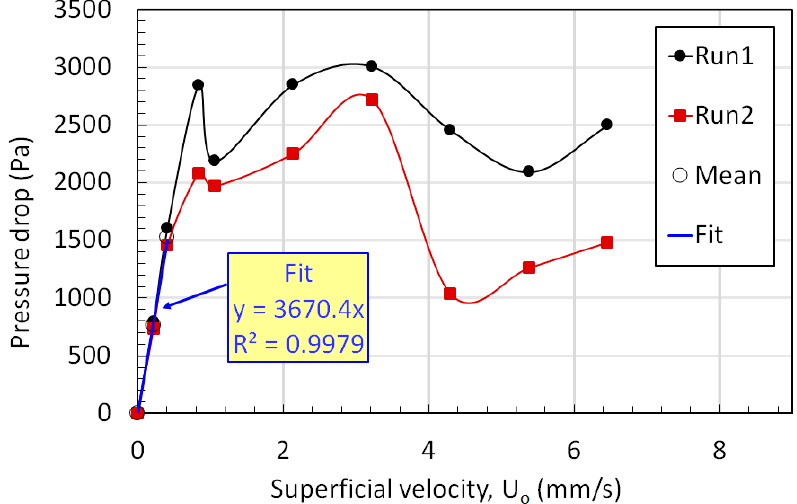
Figure 7. Effect of velocity on the pressure drop profile of the bed of calcium hydroxide during fluidization at ambient conditions using nitrogen gas (the fit is for the initial linear portion of the pressure-drop profile).